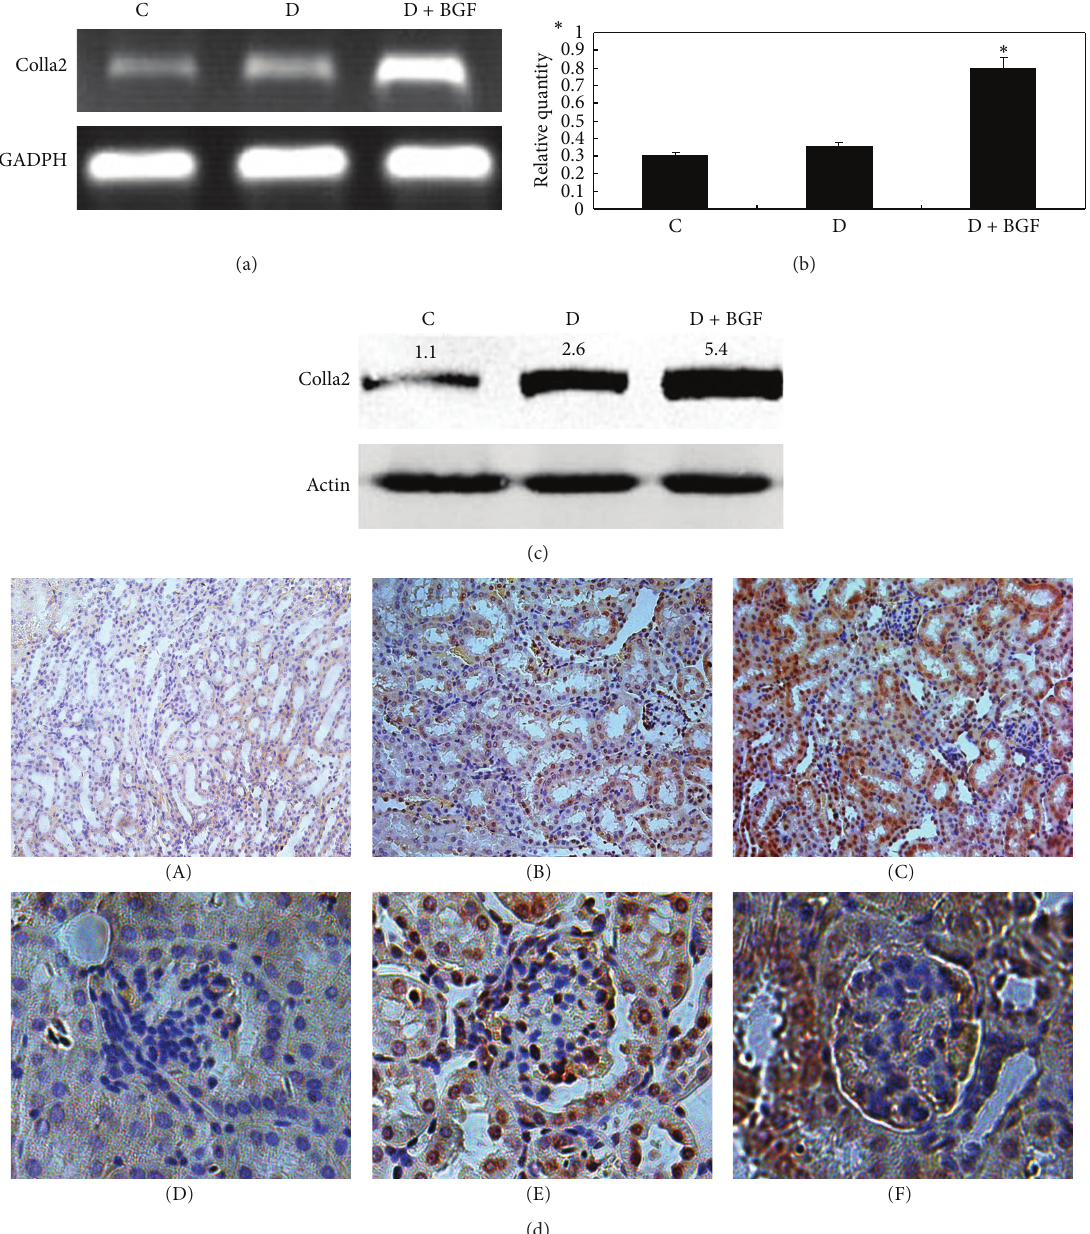
Figure 2: BGF treatment increased the synthesis of type I collagen. (a) Total RNA was extracted and analyzed for the expression of collagen in the kidney by RT-PCR. (b) GAPDH was used as an internal control. PCR products were semiquantified according to the ratio of type I procollagen mRNA to GAPDH mRNA. (b) Data are expressed as the mean ± SEM of three separate experiments. ∗ 𝑃 < 0.05 as compared to the control. (c) Western blot analysis depicted protein level of collagen in the kidney of mice. (d) Immunohistological staining of type I collagen in the kidney tissue of normal ((A), (D)), diabetic ((B), (E)), and BGF-treated ((C), (F)) mice. The rate of collagen positivity in the BGF-treated mice is higher than the other groups. Magnification: